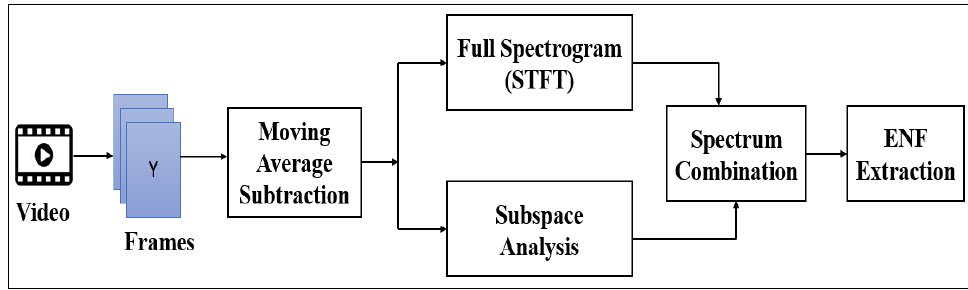
Figure 3. Framework of the proposed MUSIC approach.